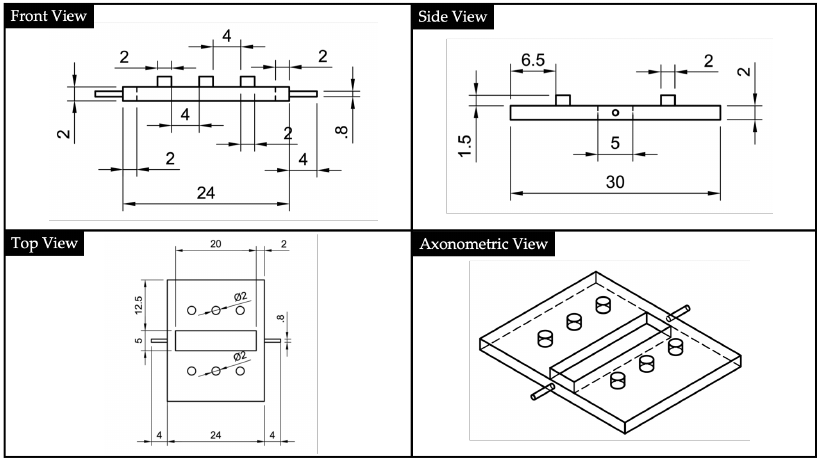
Figure 7. Mask’s 2D drawings and North-West (NW) axonometric view, obtained via Autodesk ® Fusion 360 and according with the ISO standard.